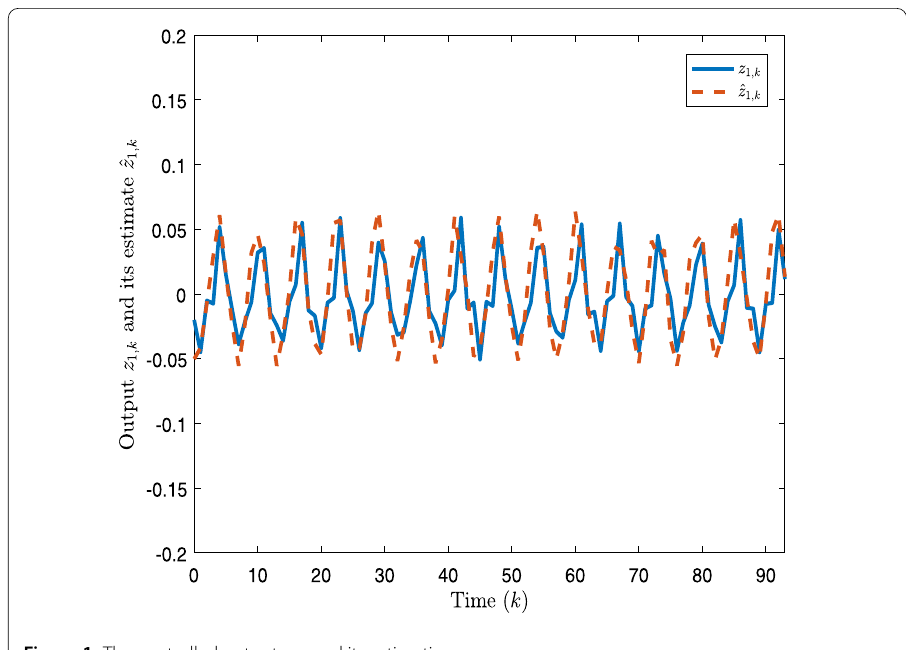
Figure 1 The controlled output z 1, k and its estimation